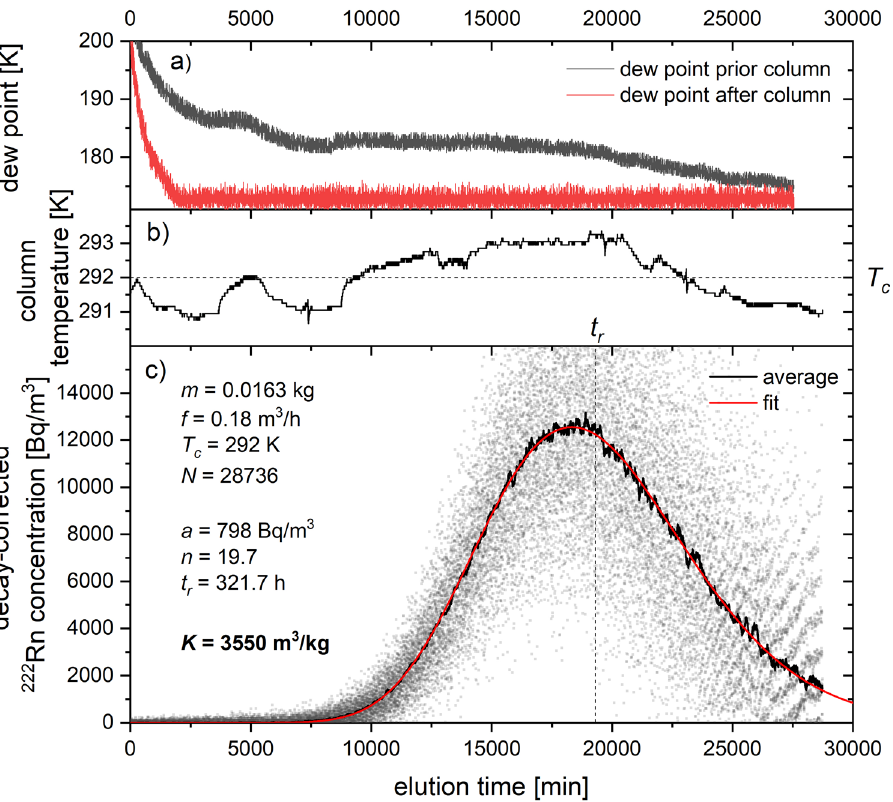
Figure 6. Experimental data for a breakthrough experiment with 16.3 g Ag-ETS-10 at a flow rate of 3 NL/ min of N 2 showing the evolution of ( a ) the dew point prior and after the adsorption column, ( b ) the column temperature and ( c ) the averaged decay-corrected 222 Rn concentration with its plate model